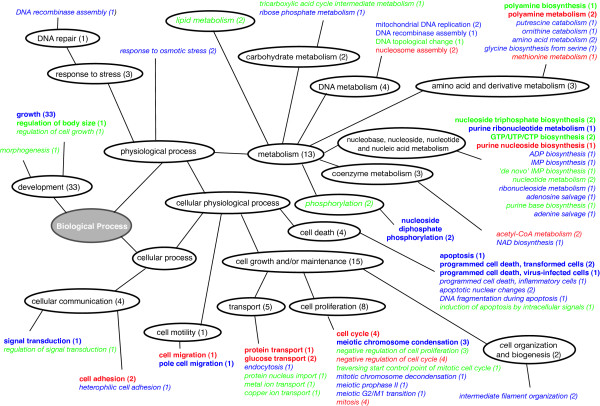
Enriched GO terms for the Down cluster. Terms highly enriched (p ≤ = 0.01) in bold and terms enriched (p ≤ = 0.05) in italic. Number of associated genes in brackets. Colors: red = terms found in GOA and PubGene, green = terms only found in GOA, blue = terms only found in PubGene.